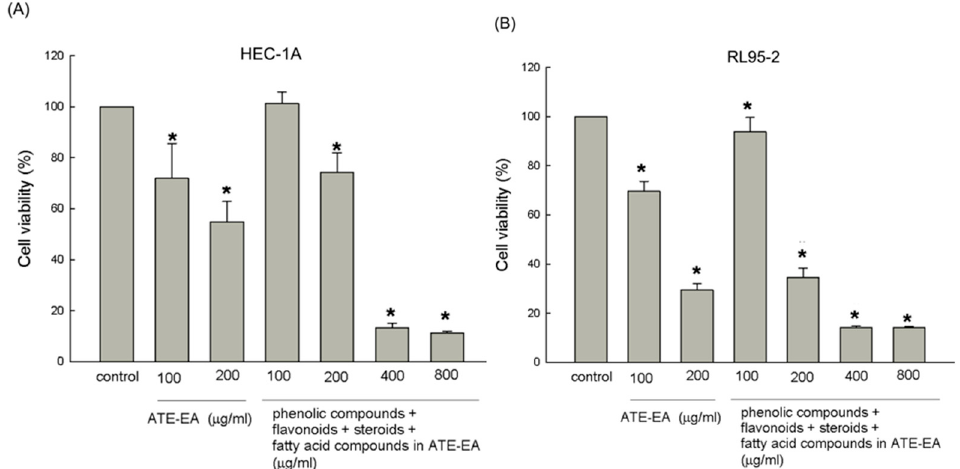
Figure 6. Effects of the mixture of four compounds from the ATE-EA on the viability of HEC-1A and RL95-2 cells. HEC-1A ( A ) and RL95-2 ( B ) cells were treated with serial concentrations of ATE-EA and four mixed compounds at a concentration of 200–800 μ g/mL for 48 h. Data are expressed as means ± SD ( n = 3). * p < 0.05, compared with the control group at the basal level. ATE-EA, ethyl acetate fraction of the adlay testa ethanolic extract.